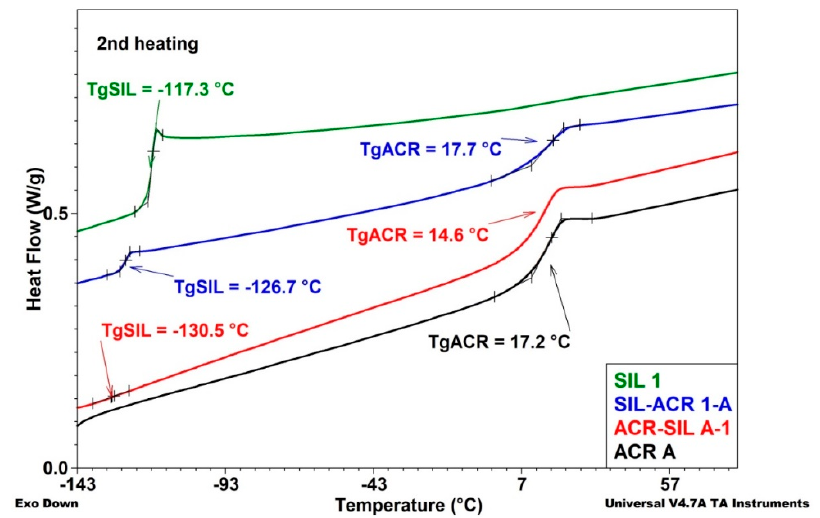
Figure 9. Differential scanning calorimetry (DSC) patterns determined for starting SIL and ACR dispersions and for SIL-ACR and ACR-SIL dispersions having the same composition of ACR and SIL parts. Only for two dispersions (ACR-SIL A-2 and ACR-SIL B-2) just one T g was detected at around 16